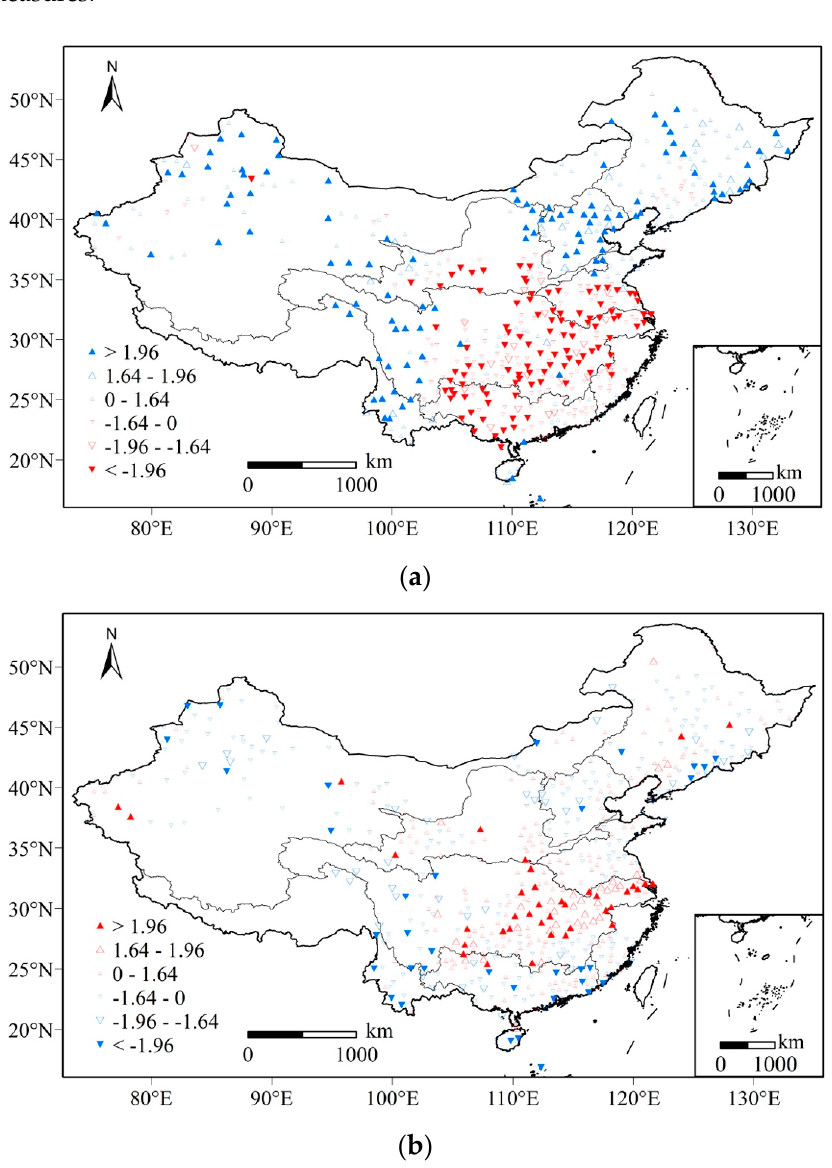
Figure 3. ( a ) Modified Mann–Kendall trend of spring precipitation; and ( b ) extreme drought frequency at 10% and 5% significance levels. at 10% and 5% significance